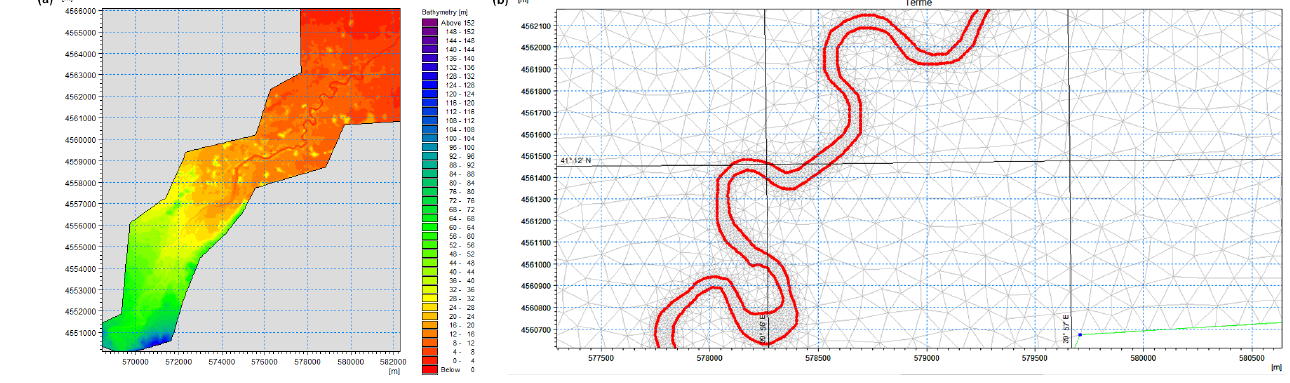
Figure 2. DTM (a) and flexible mesh (b) of the study area. Table 4. Scenario3 model